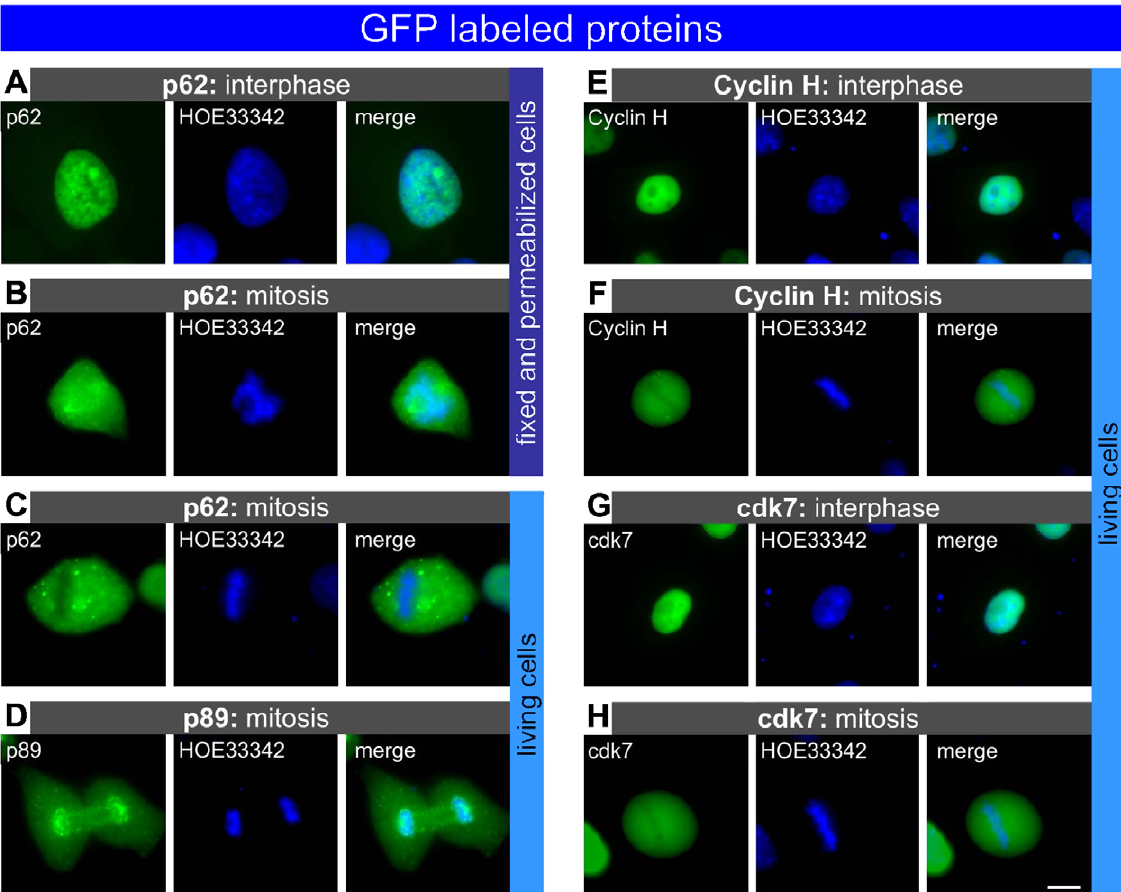
Fig. 6. Localization of other TFIIH subunits during mitosis. (A) Nuclear localization of GFP-p62 in interphase cells. During mitosis, GFP-p62 can be visualized at the centrosome only following (B) cell permeabilization, (C) but not in un-permeabilized living cells. (D) In contrast, GFP-p89 revealed the known centrosomal association also in living cells. GFP-labelled (E) cyclin H and (G) cdk7 showed a similar nuclear distribution in interphase. During mitosis, no significant spindle or centrosomal localization was detectable in (F) cyclin H- or (H) cdk7-transfected cells, respectively. Scale bar = 10 µm.